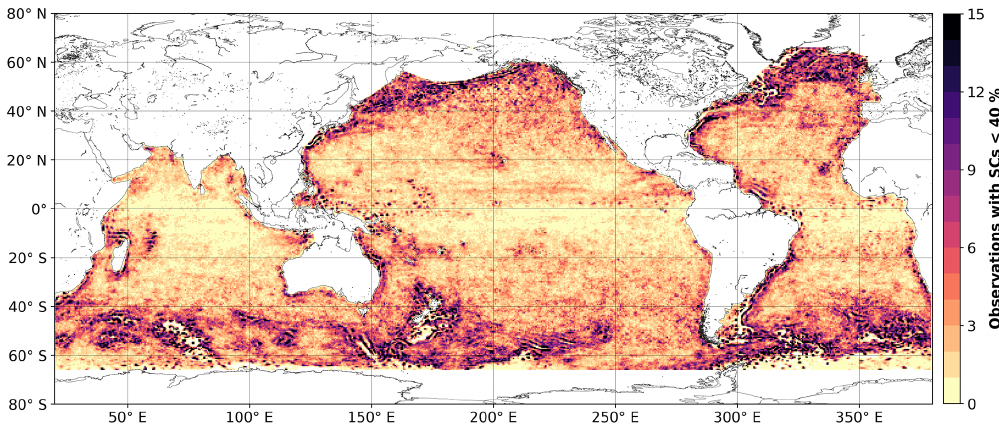
Figure 5. Number of eddy centers associated with ADT-detected eddies that are unmatched or matched with low similarities indexes (SCs < 40%) with SLA-detected eddies.